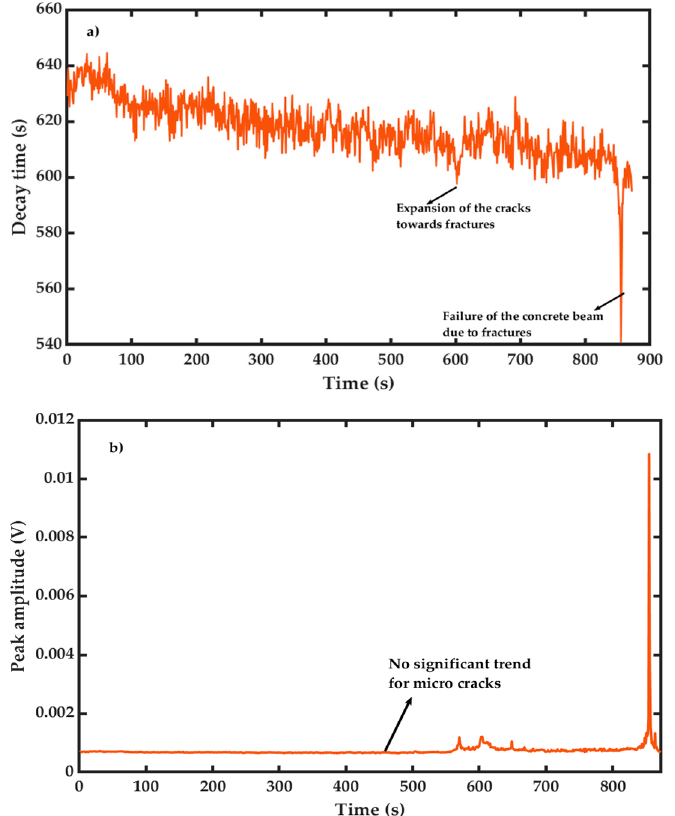
Figure 10. Time history of ( a ) the decay time (a reliable feature) and ( b ) peak amplitude (an unreliable feature).